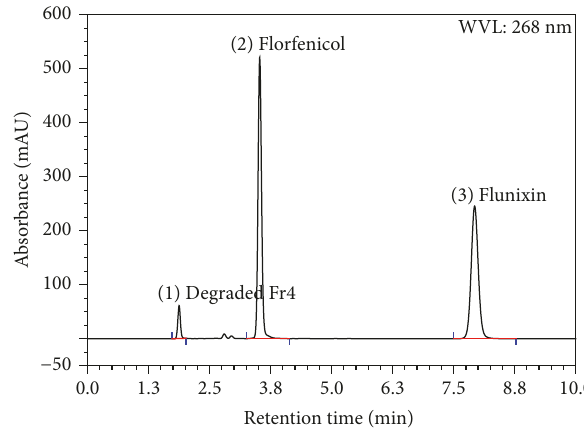
Figure 6: Chromatogram of Flr and Flx under thermal stress testing condition of 75 ∘ C for 14